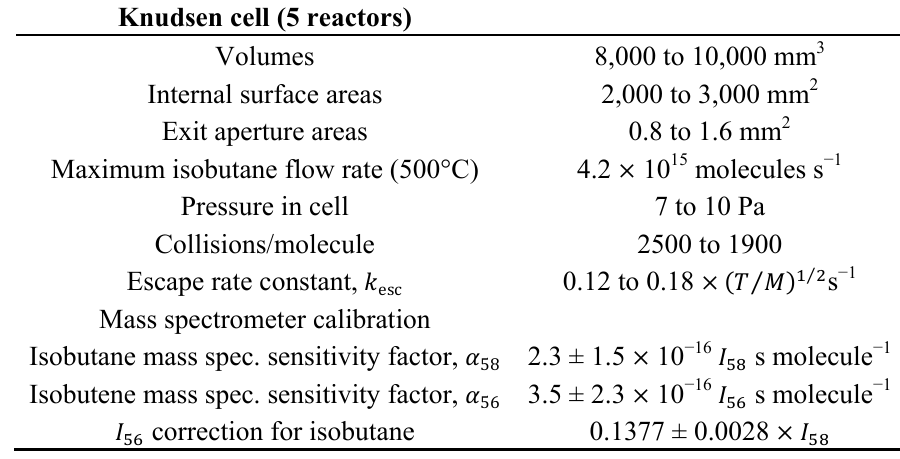
Table 7. List of specifications for the Knudsen cell reactors and mass spectrometer calibration and correction factors. Maximum isobutene flow rate is estimated by equating the largest cell dimension ( ca. 40 mm) with the isobutane mean free path